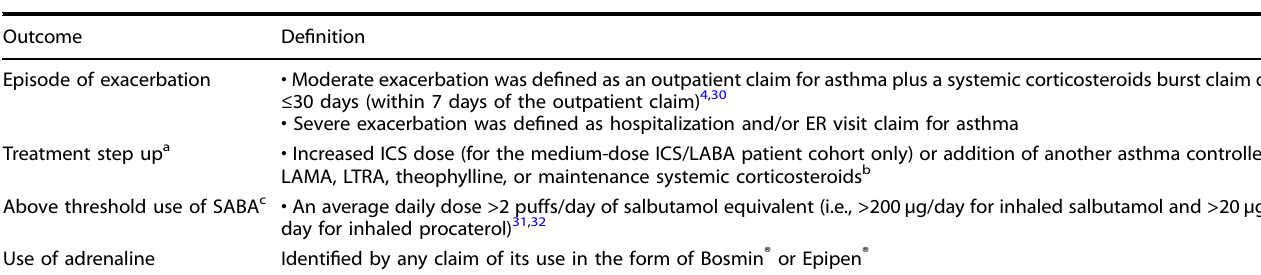
Table 4. Uncontrolled asthma